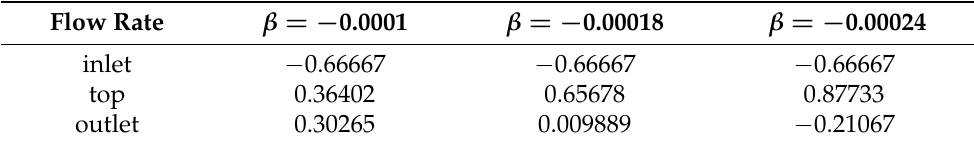
Table 4. Computed flow rates at inlet, top wall, and outlet for different values of β . The numerical parameters used are h = 1/160 and δ =